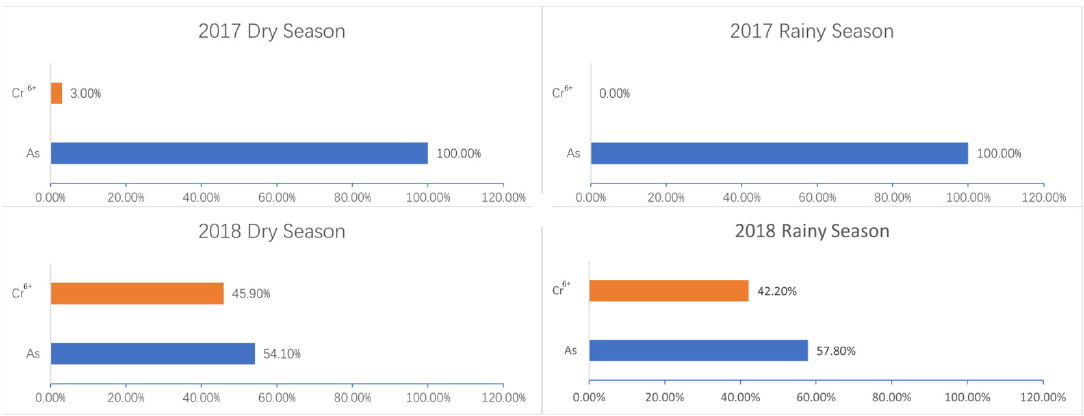
Figure 6. Sensitivity of As and Cr.